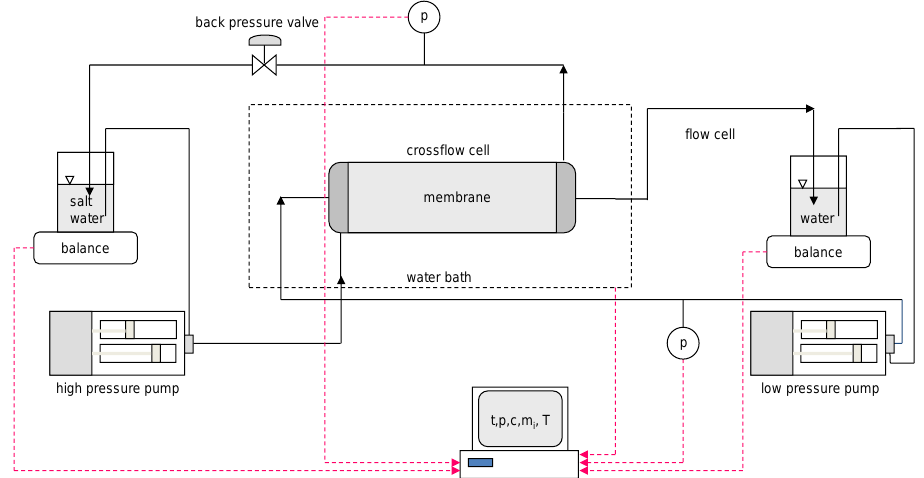
Figure 2. Simplified flow diagram for the two cross flow apparatuses used in the study.